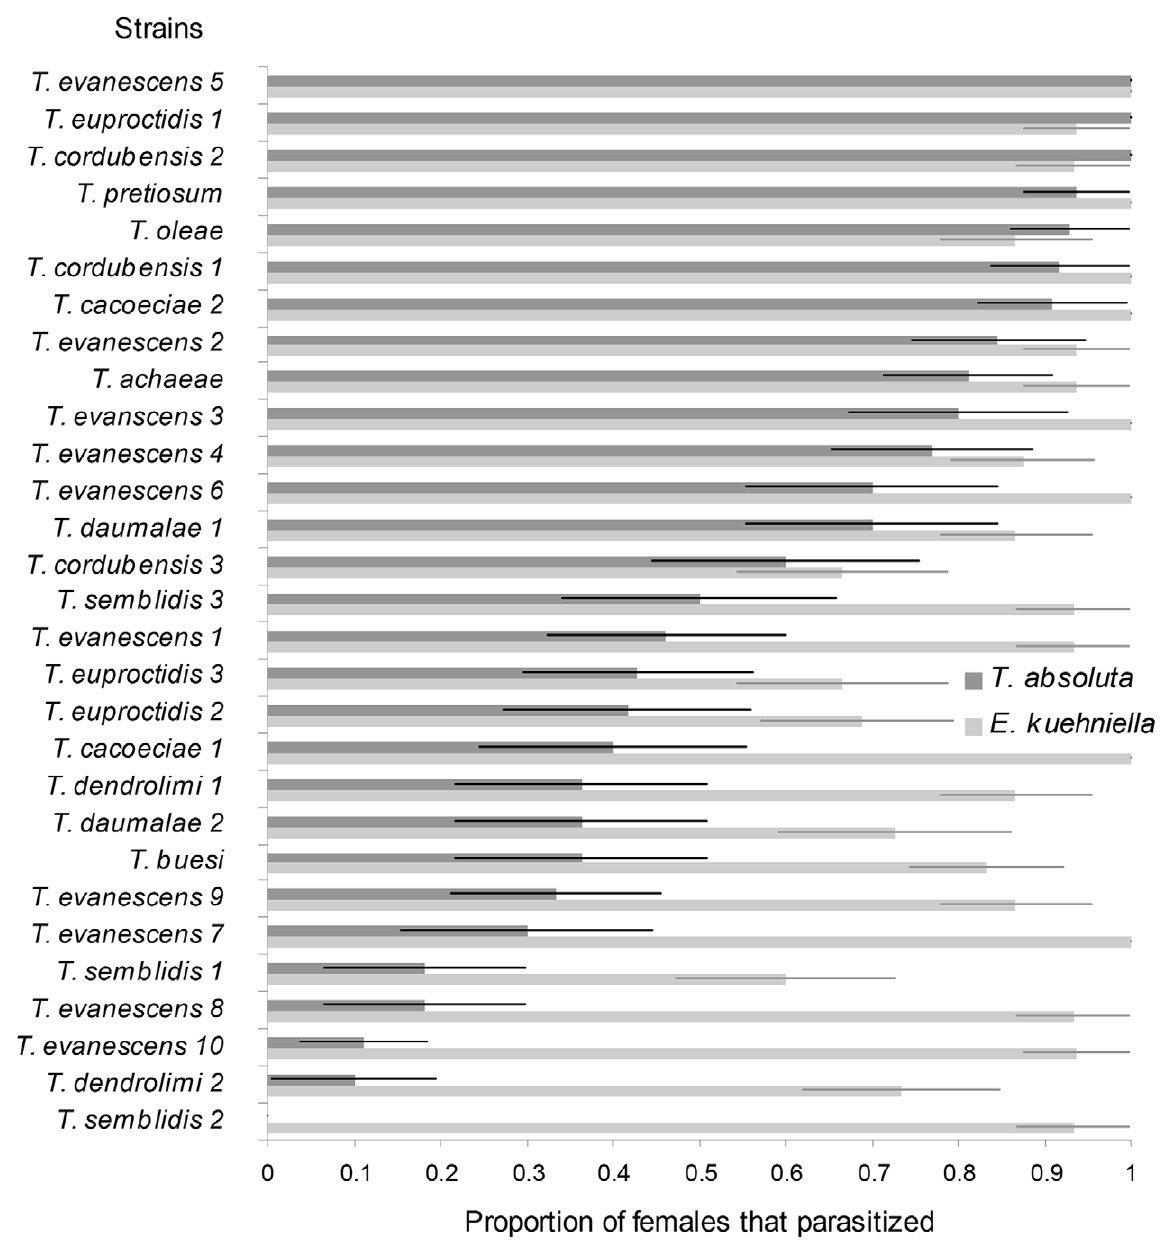
Figure 2. Acceptance of two hosts, Tutaabsoluta and Ephestiakuehniella , by Trichogramma females. Data are presented as proportions (mean 6 SEM) of Trichogramma females that parasitized at least one egg on T. absoluta and on E. kuehniella in laboratory screening tubes.